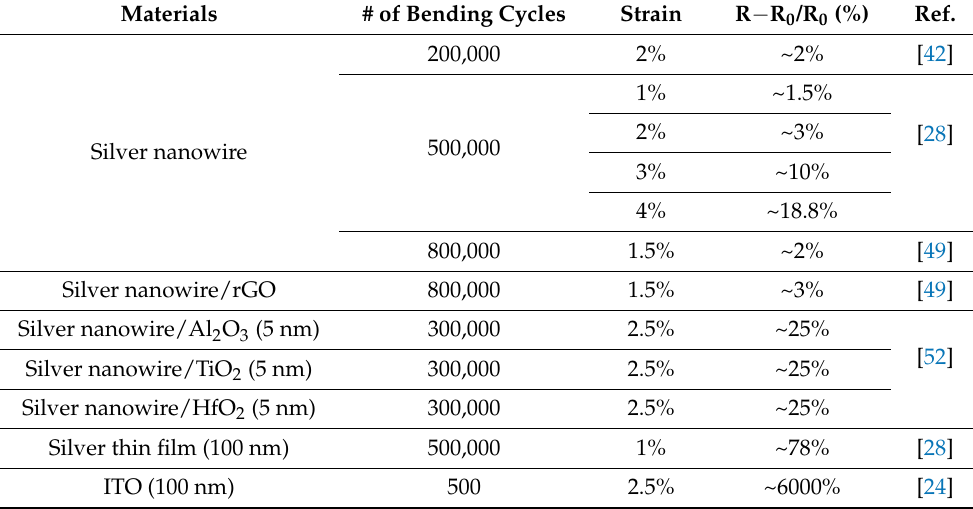
Table 1. Comparison of the change in resistance of different materials after high-cyclic bending.